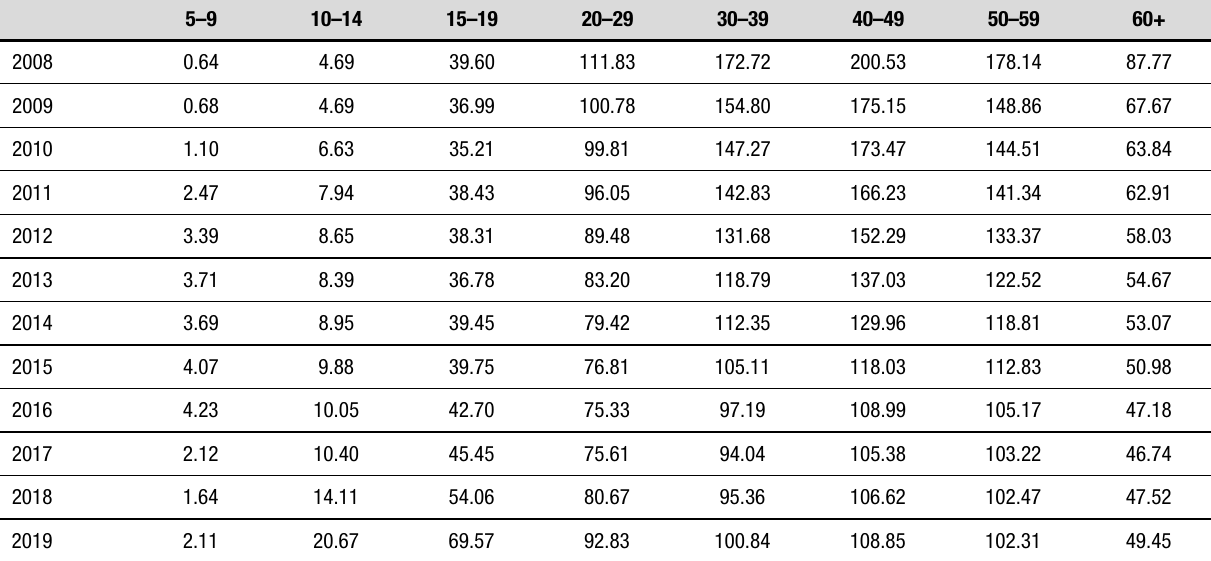
Table 3. Incidence of schizophrenia and common mental disorder by age